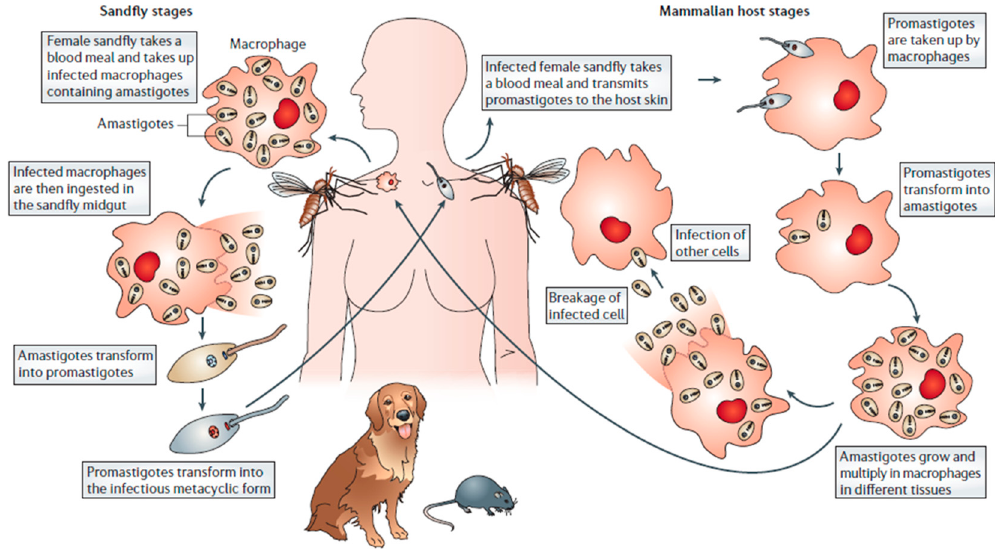
Figure 1. Schematic representation of the infection cycle of leishmaniasis (from [5]).